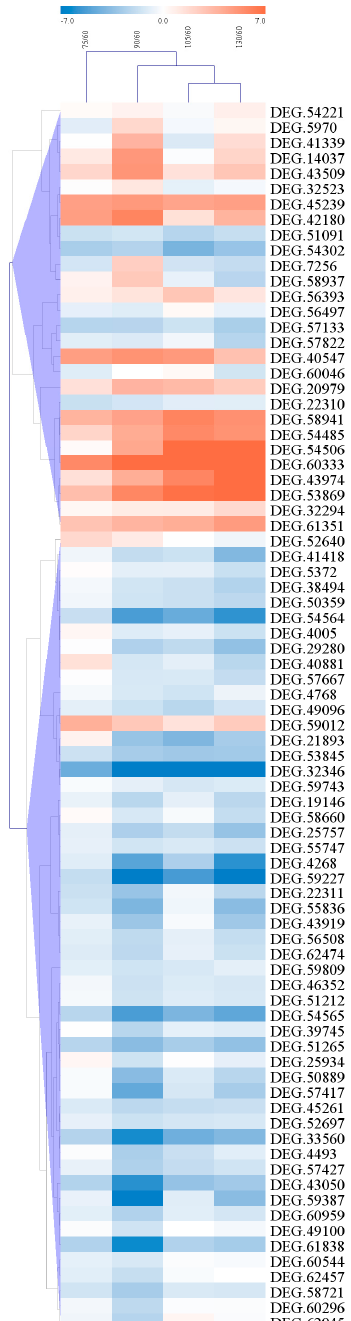
Figure 5. Expression changes and cluster analysis of genes (80 in total) that were differentially expressed between the 75 DAF and 60 DAF (control), 90 DAF and 60 DAF, 105 DAF and 60 DAF, and 135 and 60 DAF contrast groups. The heatmap was generated using Multiple Array Viewer. The rows represent the differentially expressed genes, whereas the columns shows the different contrast groups. Red, blue, and white boxes represent genes showing increased, decreased, or equal expression levels, respectively. Color saturation reflects the magnitude of log2 expression ratio of the RPKM for the four developmental stages and 60 DAF.